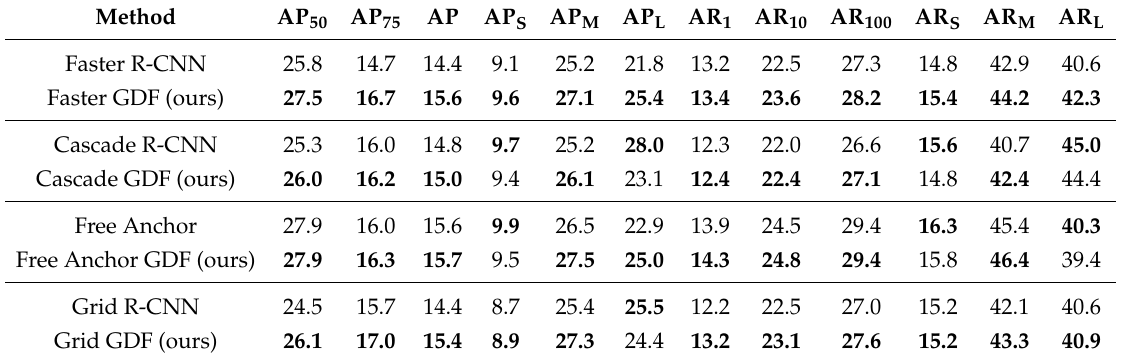
Table 2. Comparisons of detection performance on the UAVDT dataset.